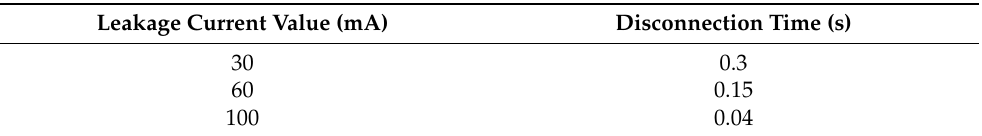
Table 1. Leakage current values and their corresponding disconnection times listed in the VDE 0126-1-1 standard [26].